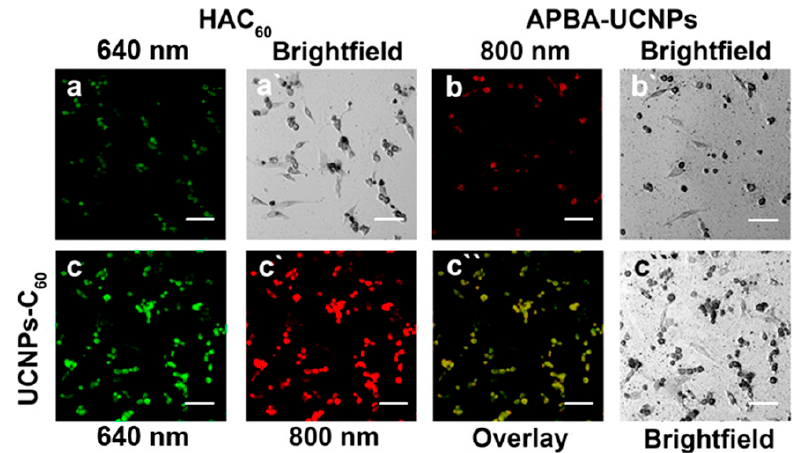
Figure 3. Confocal microscopic images of PC12 cells incubated with APBA-UCNPs (100 µg·mL − 1